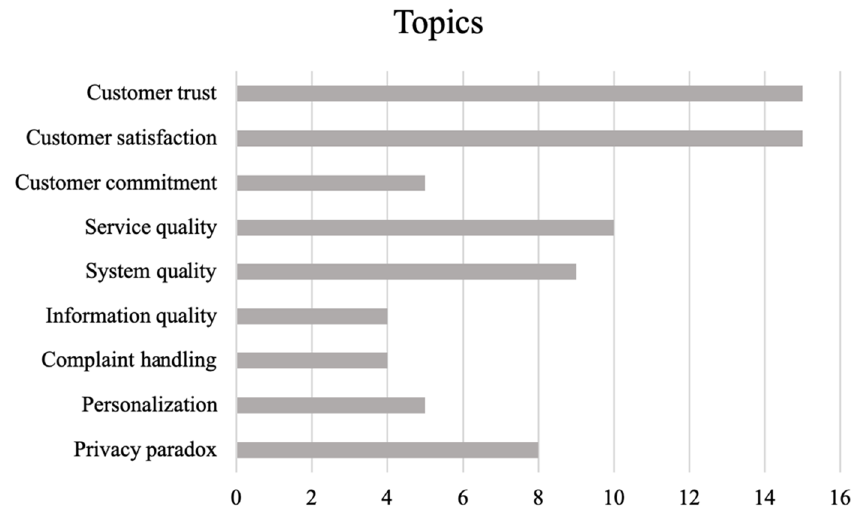
Figure 4. Topics of the selected papers.